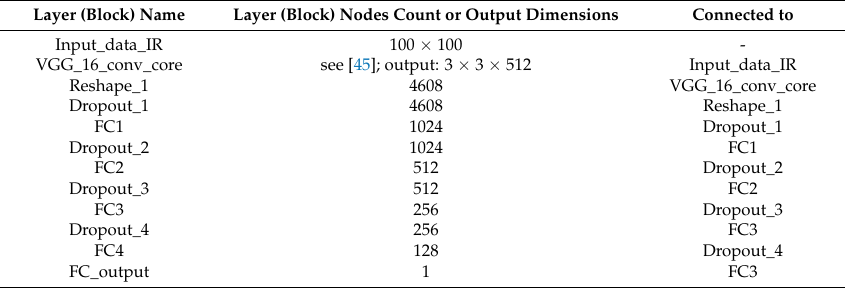
Table A1. CNN #3 and CNN #5 best hyper-parameters combination.